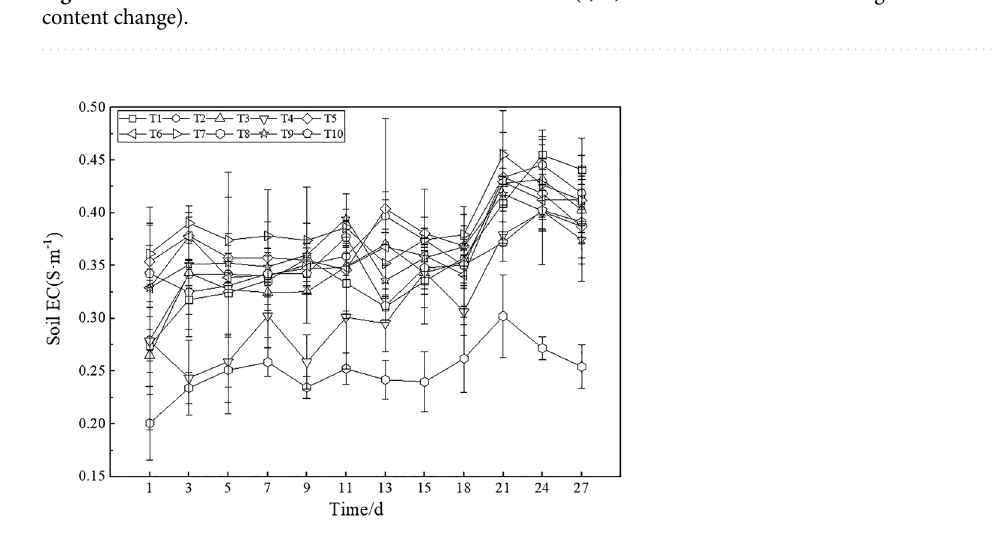
Figure 7. Soil EC under the different